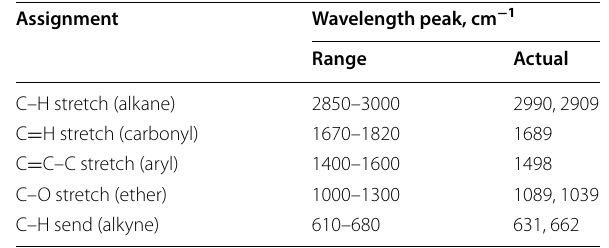
Table 3 The main peak of the FTIR spectrum of